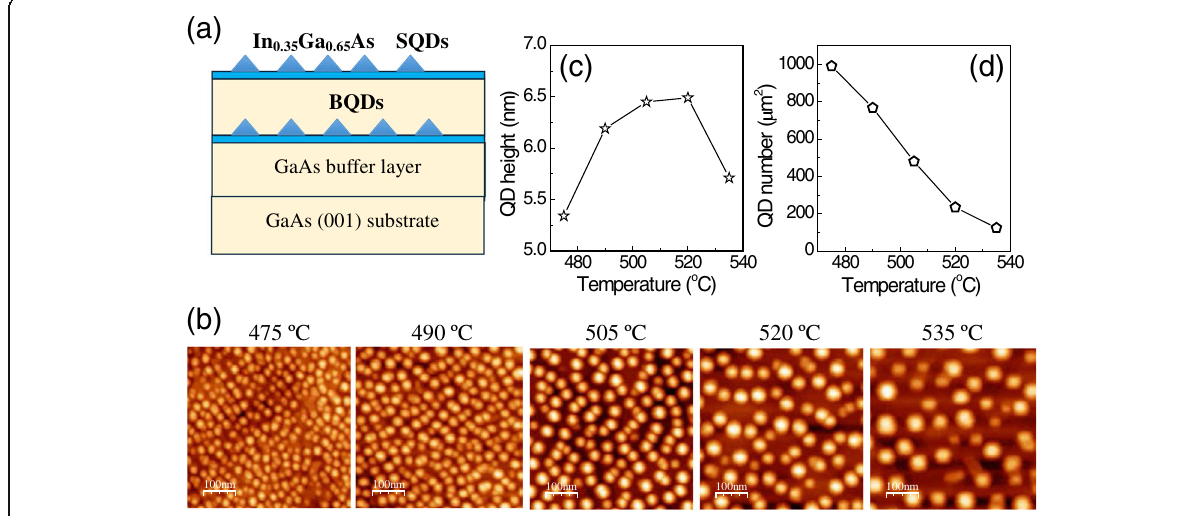
Fig. 1 a The schematic diagrams of the SQD sample structure. b 0.5 μ m × 0.5 μ m AFM images of the InGaAs SQDs grown at different temperatures. c The average height and d areal density of the InGaAs SQDs are plotted with respect to the growth